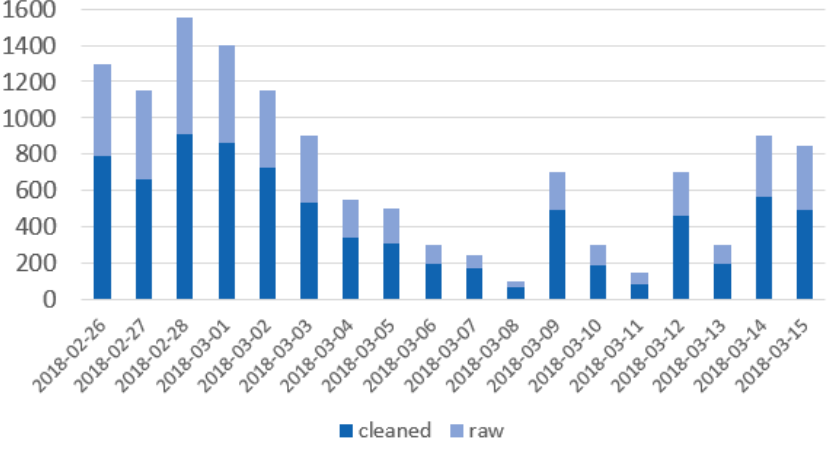
Figure 3. Number of tweets per day (showing also the number of tweets in the raw corpus and after data cleaning).